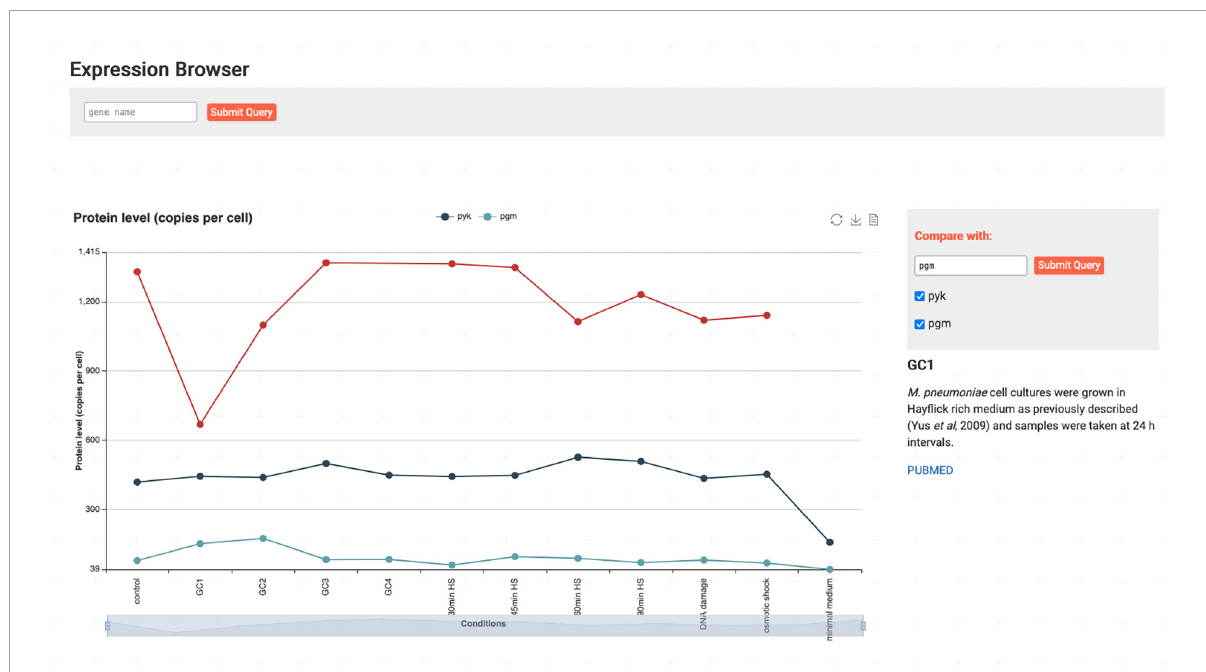
FIGURE5 The Expression Browser shows protein levels and transcript levels (not included in the screenshot) for genes under various conditions. Data on additional genes can be loaded via the search bar for comparison. Here, protein levels for Eno are compared with Pyk and